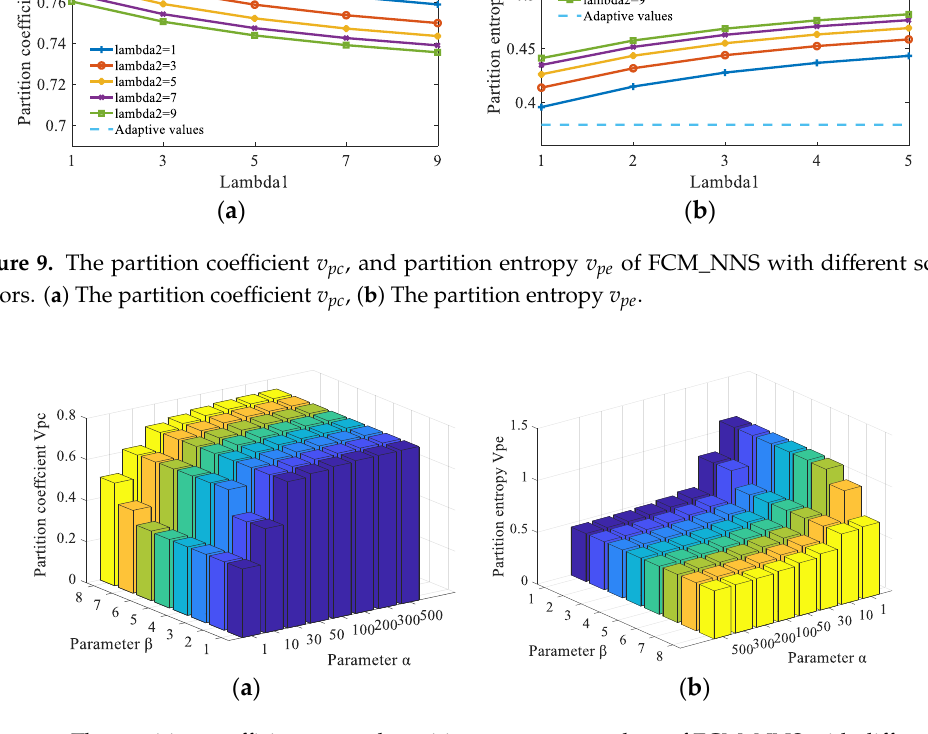
and β . ( a ) The partition coe ffi cient v pc , ( b ) The v pe partition entropy different  and  . ( a ) The partition coefficient pc v , ( b ) The pe v partition entropy values.